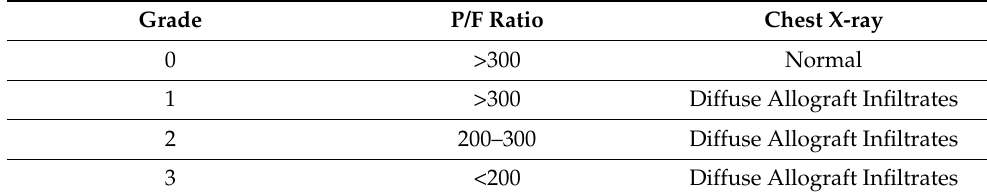
Table 1. ISHLT PGD grading